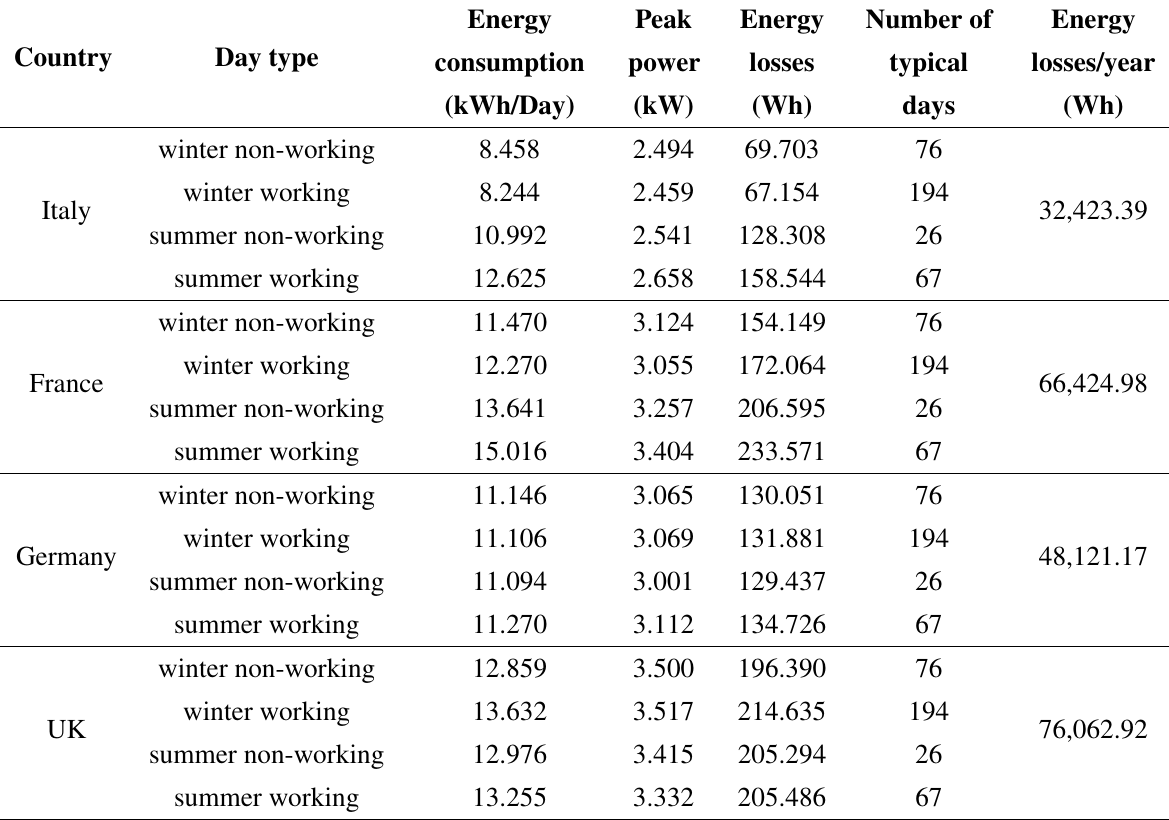
Table 5. House energy losses per country-scenario